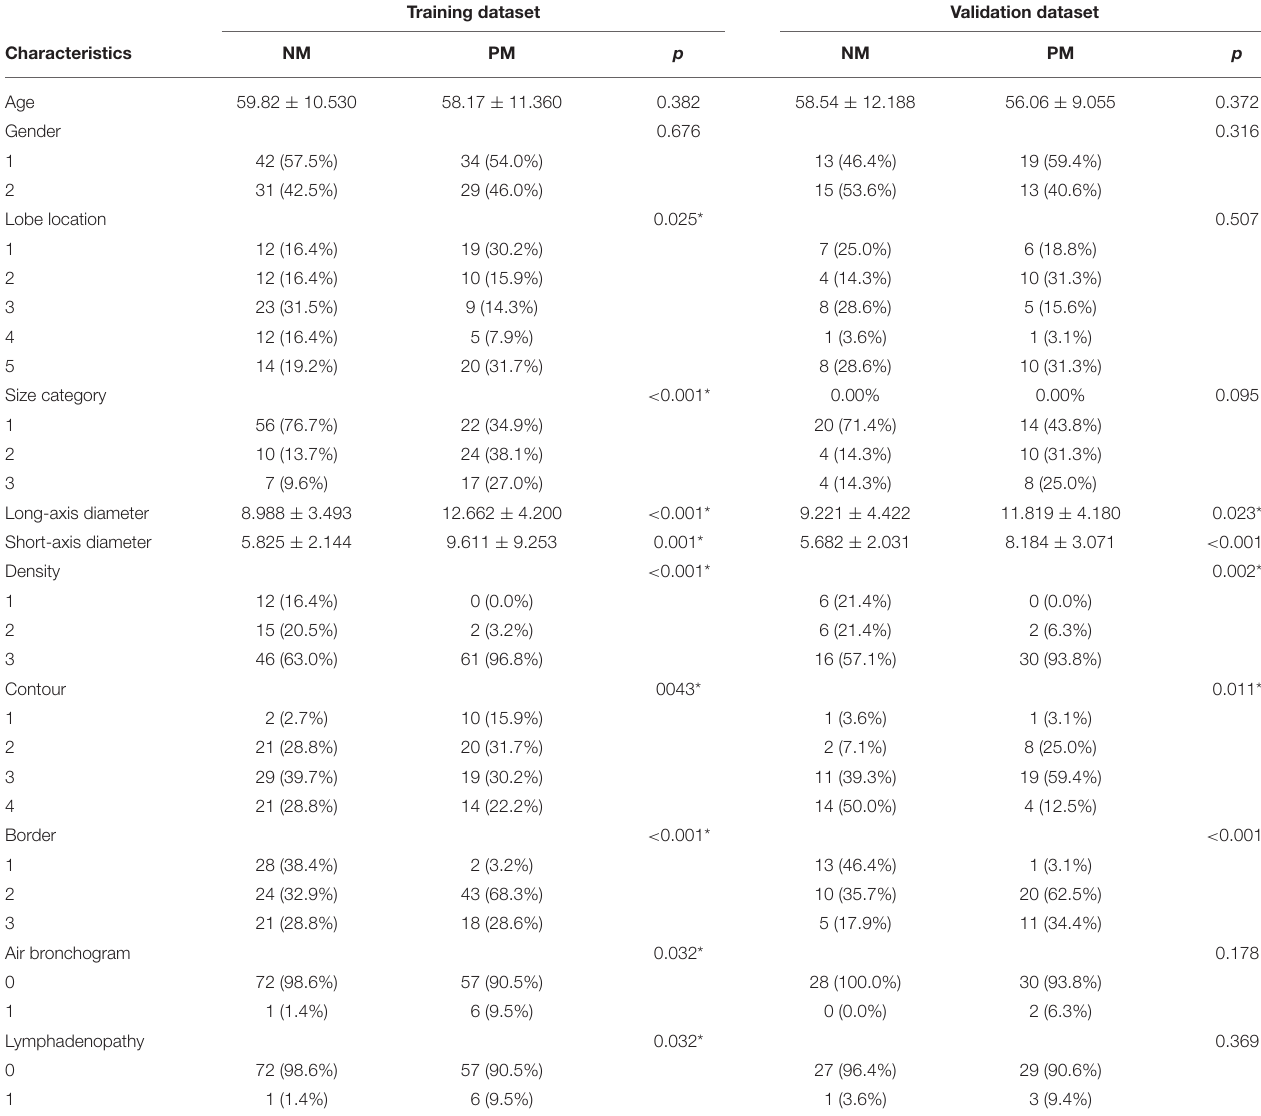
TABLE 1 | Comparison of morphological features of lung metastasis (PM) and non- metastasis (NM) in the training and validation datasets. Training dataset